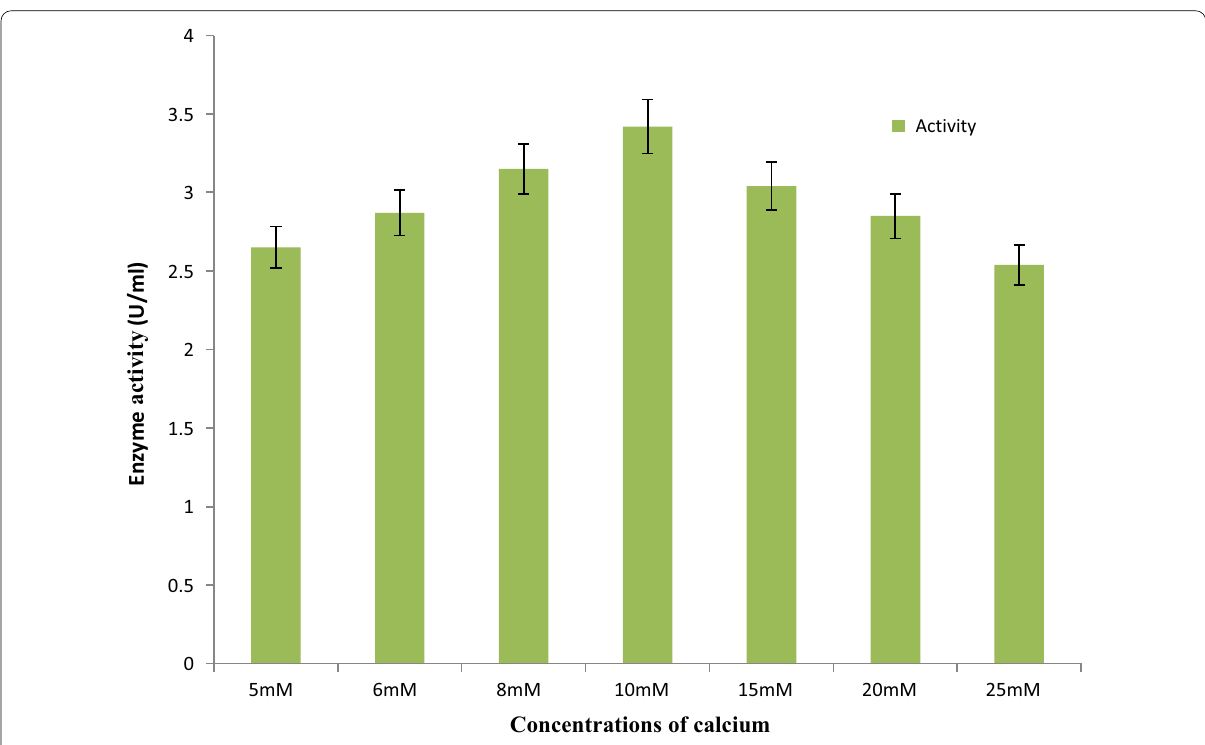
Fig. 9 Effect of different concentrations of calcium on enzyme